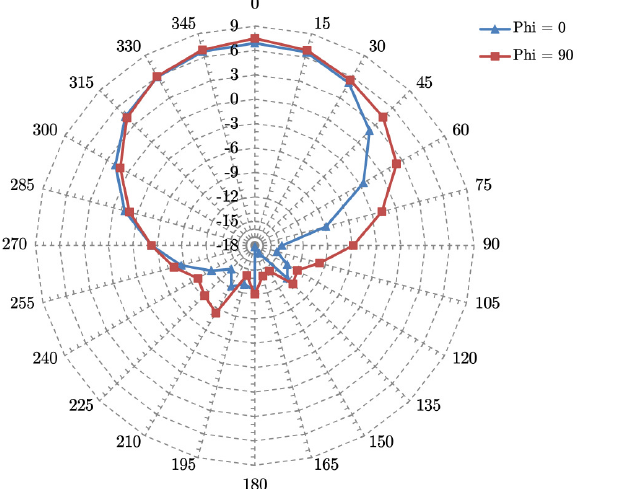
Figure 12. Horizontal (phi = 0) and vertical (phi = 90) antenna pattern of the ISL and downlink antenna.